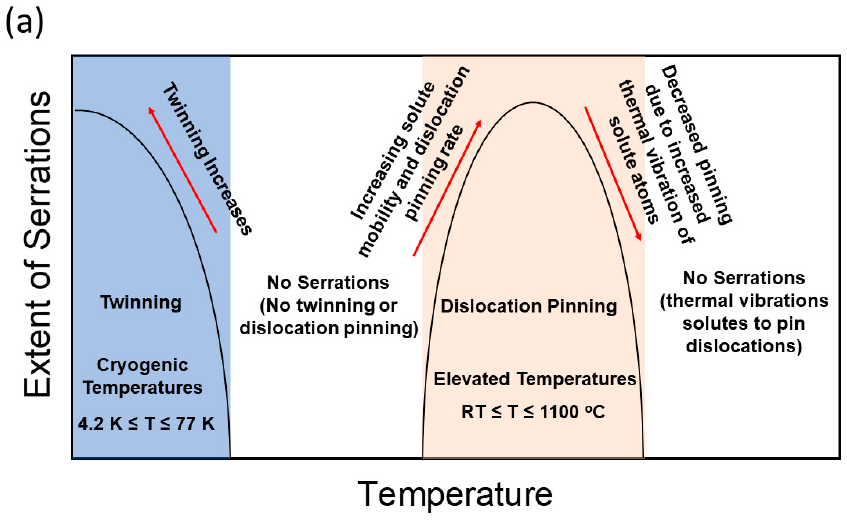
Figure 48. A graphical representation of the reported results that are listed in Table 8 for serration